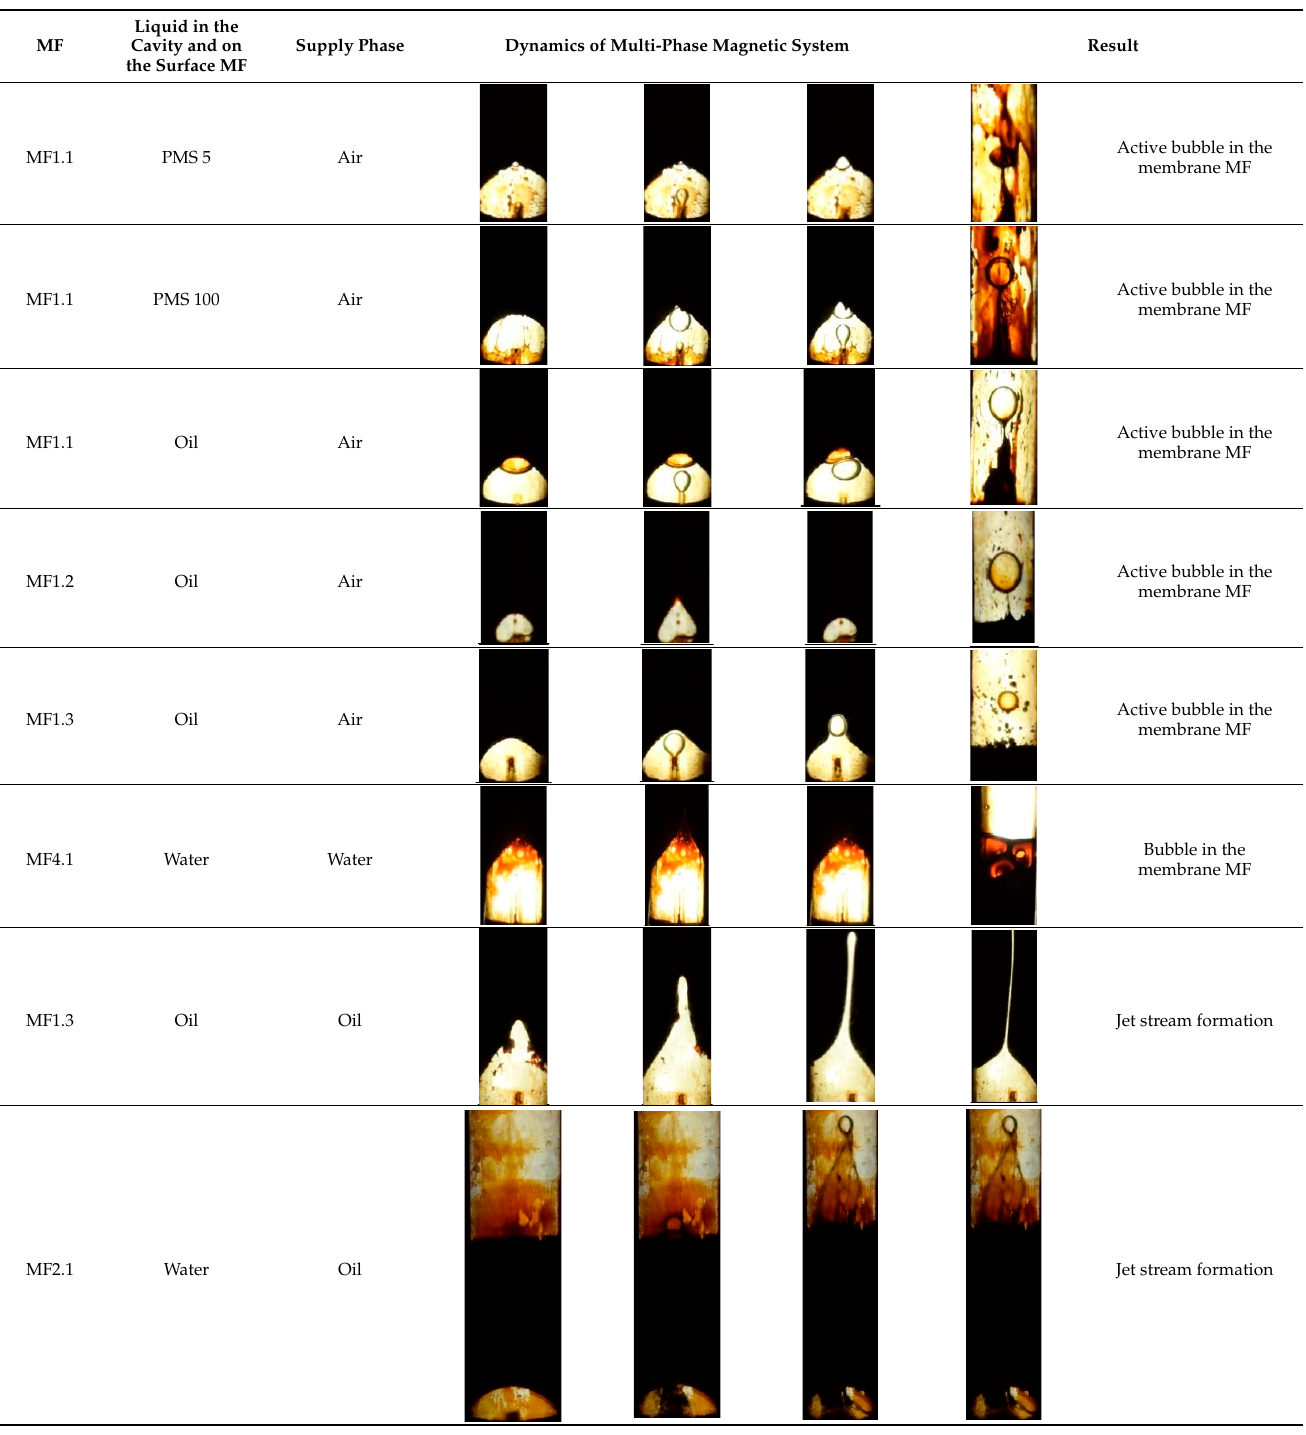
Table 5. Dynamics of active bubbles in the multiphase system MF-oil.